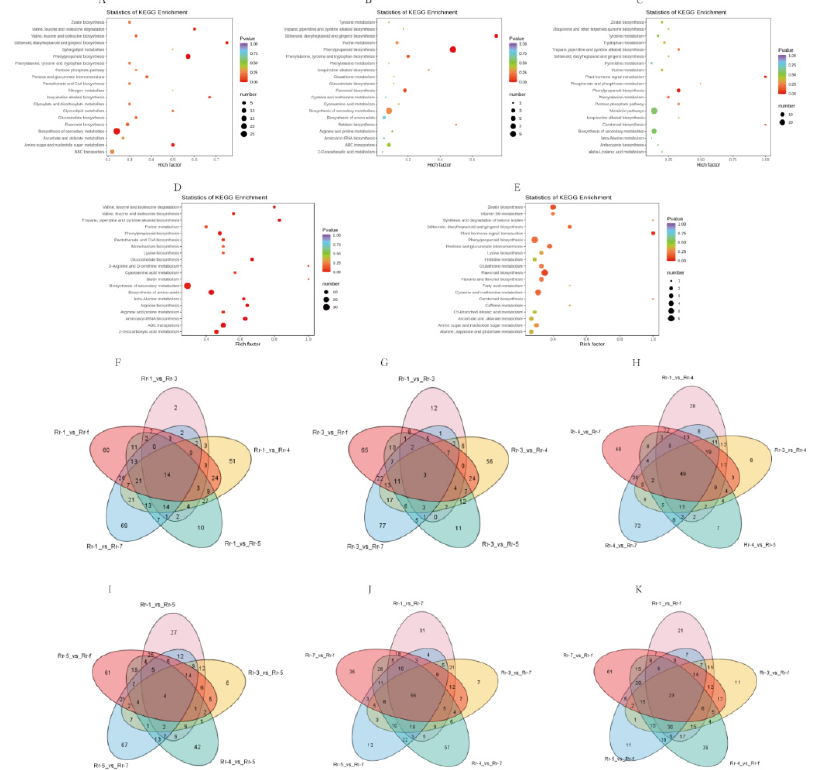
Figure 4. ( A – E ) KEGG enrichment analysis of the DAMs between Rr-5 and the other five genotypes. ( A ) Rr-1 vs. Rr-5. ( B ) Rr-3 vs. Rr-5. ( C ) Rr-4 vs. Rr-5. ( D ) Rr-7 vs. Rr-5. ( E ) Rr-f vs. Rr-5. ( F – K ) The Venn diagram shows the overlapping and unique DAMs among different genotypes. ( F ) Rr-1 vs. other genotypes. ( G ) Rr-3 vs. other genotypes. ( H ) Rr-4 vs. other genotypes. ( I ) Rr-5 vs. other genotypes. ( J ) Rr-7 vs. other genotypes. ( K ) Rr-f vs. other